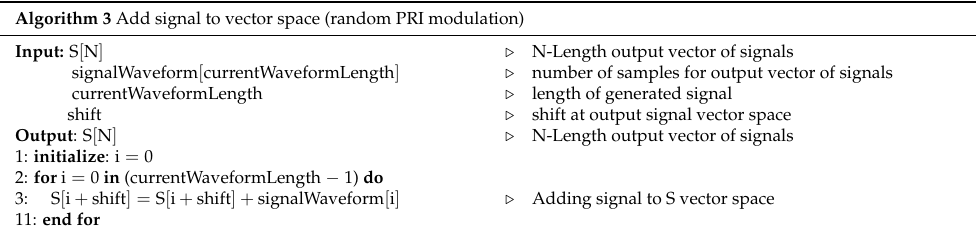
Algorithm 3 Add signal to vector space (random PRI